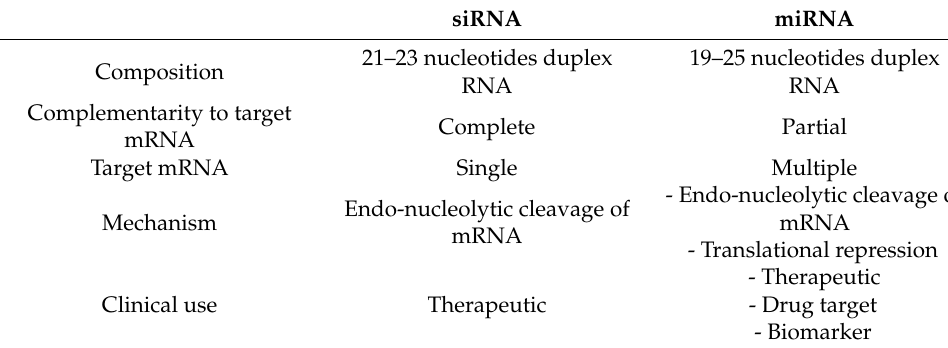
Figure 1. Chemical structure of ( A ) Chitosan (CS) and ( B ) Tri Methyl Chitosan (TMC). Table 1. General comparison between siRNA and miRNA. [8].